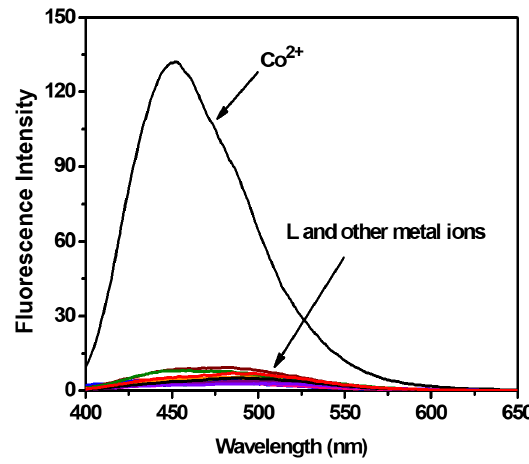
Figure 2. Fluorescence spectra ( λ ex = 380 nm) of the L sensor (1 × 10 -5 mol L -1 ) before and in the presence of five equivalents of various metal ions (Na + , K + , Ag + , Cu + , Mg 2+ , Zn 2+ , Ca 2+ , Sn 2+ , Cu 2+ , Ni 2+ , Mn 2+ , Pb 2+ , Cd 2+ , Ba 2+ , Hg 2+ , Fe 2+ , Co 2+ , Fe 3+ , Al 3+ and Cr 3+ ) in a CH 3 CN/HEPES (4/1, v / v , pH = 7.4) solution.